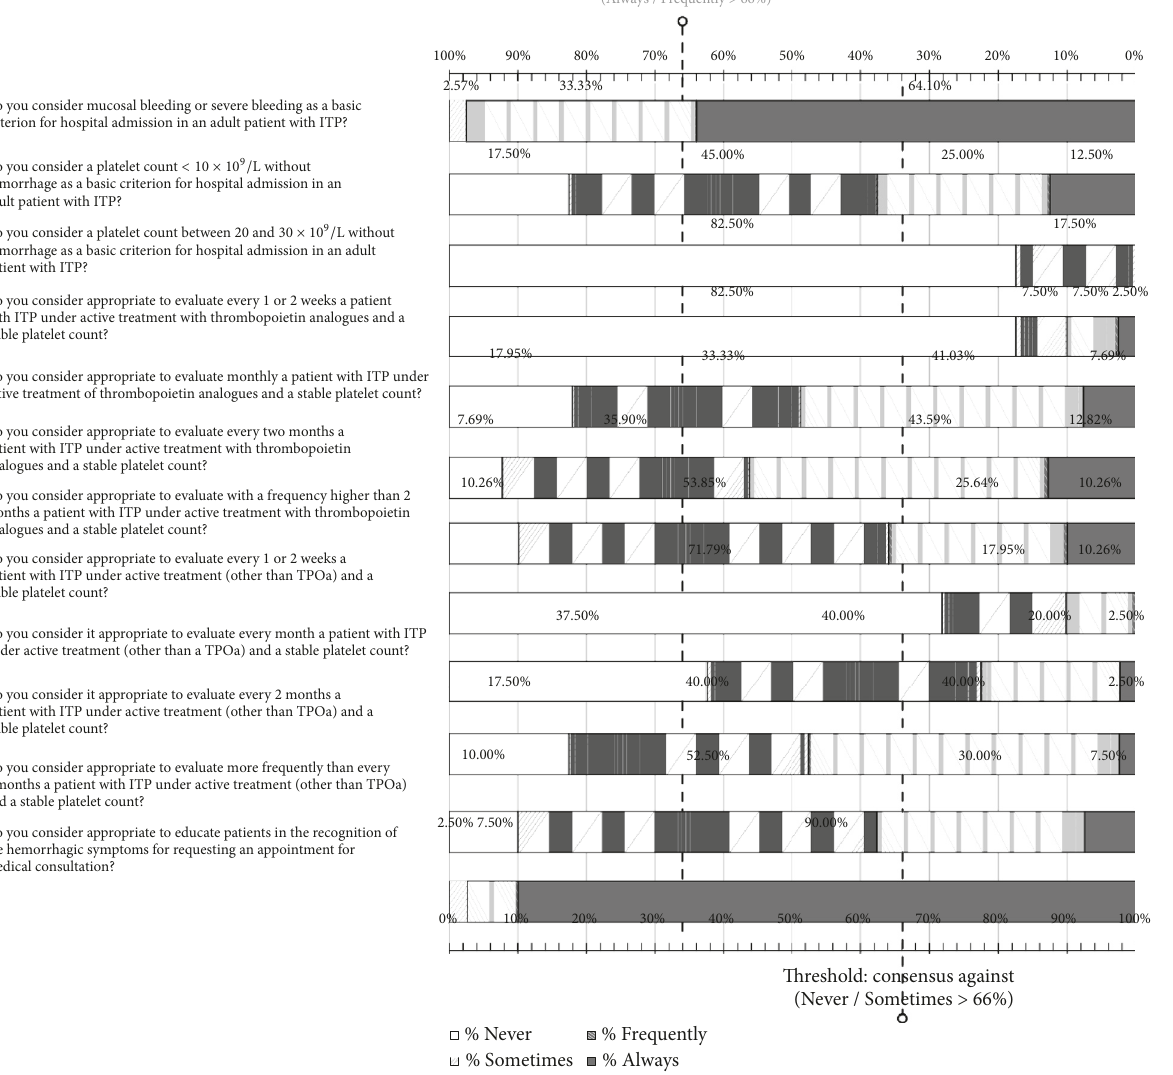
Figure 4: Results obtained in the section of the questionnaire regarding the follow-up of patients with ITP. Distribution of the percentages of